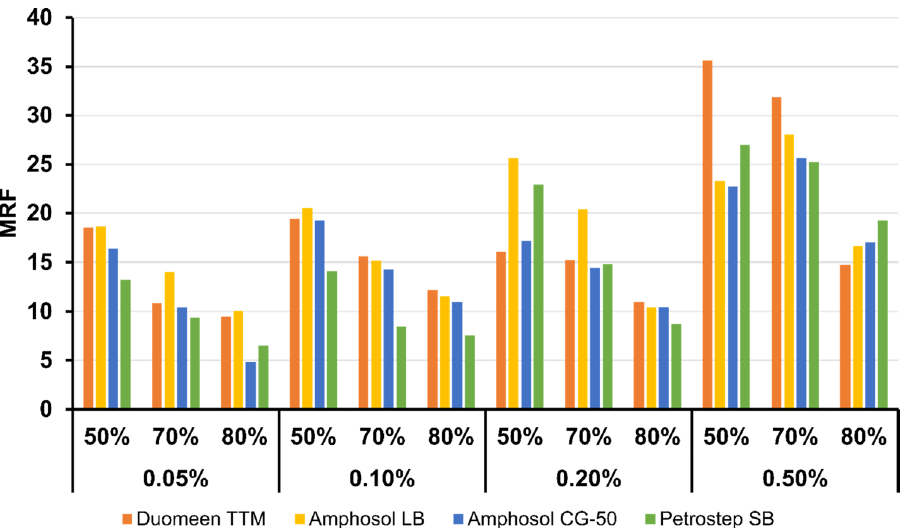
Figure 8. Mobility reduction factors for Sc-CO 2 foams with surfactants Duomeen TTM, Amphosol LB, Amphosol CG-50, and Petrostep SB, at concentrations of 0.05, 0.1, 0.2, and 0.5 wt% and foam qualities of 50, 70, and